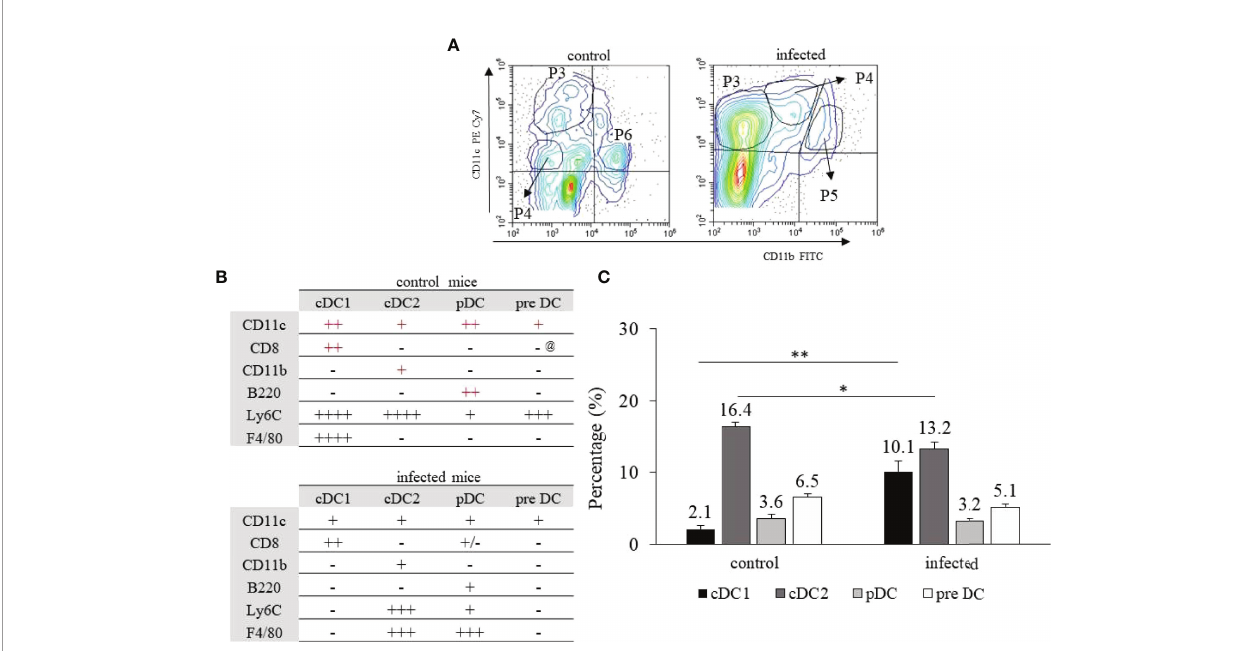
FIGURE 1 | Hepatic dendritic cells ’ identi fi cation and cellular frequency after T. cruzi infection. C57BL/6 mice were infected with 1x10 4 blood trypomastigote forms of T. cruzi Y strain and on dpi 15, infected and control mice were euthanized. The HDCs we isolated by enzymatic dissociation and primarily identi fi ed according to the expression of CD11c and/or CD11b (A) . In control mice, cDC1 and pDC were identi fi ed in P3, cDC2 in P6, and pre DC in P4. In infected mice, cDC1 and pre DC were identi fi ed in P3, pDC in P4, and cDC2 in P5 (A) . The complete phenotype to discern cDC1, cDC2, pDCs, and pre DCs is depicted in B and the frequency of each cellular population is shown in (C) @ Indicates that most pre DCs from control mice do not express CD8 and, therefore, were represented as (-), but about 15% of the cells were CD8 + . The primary canonic phenotype for each population is shown in red (B) . * means statistical signi fi cance (p ≤ 0.05) using the Kruskal Wallis test followed by Dunn ’ s post-test, and ** means p ≤ 0.01 using the one-way ANOVA test followed by the Tukey ’ s